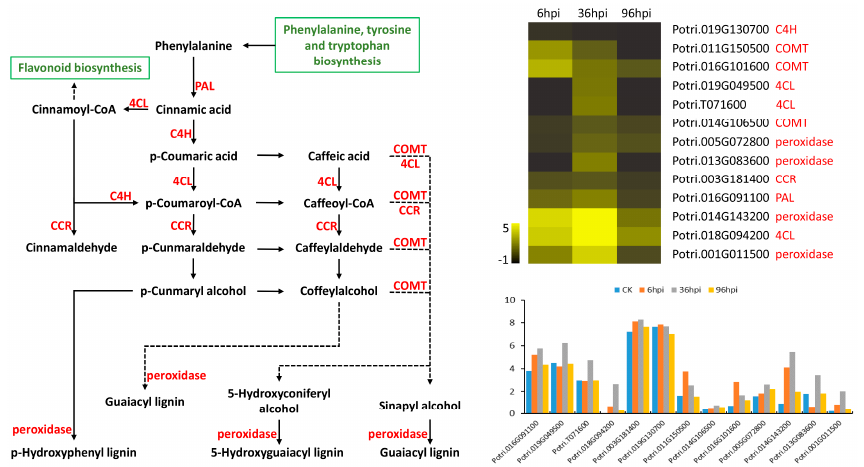
Figure 8. The gene expression pattern of some genes involved in the phenylpropanoid biosynthesis pathway of Aig. Pathway shows genes (in red) and productions in the pathway. The row of heat map represents a gene and the column represents an infection stage. The gene id and annotation are shown on the right of heat map. Histogram shows the gene expression of each gene with the value of log 2 (FPKM + 1). Related pathways are showed in boxes (green). 4CL : 4-coumarate-CoA ligase; C4H : cinnamate 4-hydroxylase; CCR : cinnamoyl-CoA reductase; COMT : caffeic acid 3- O -methyltransferase; PAL : phenylalanine